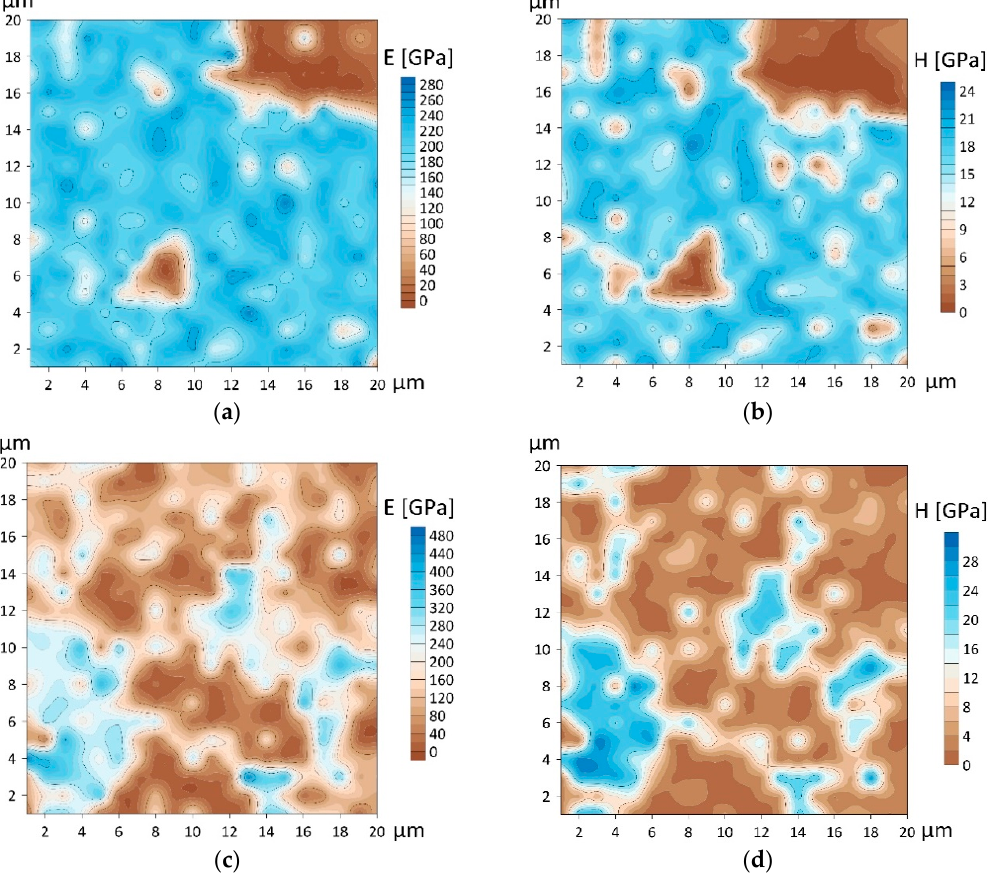
Figure 16. Elastic modulus ( a , c ) and microhardness ( b , d ) maps of CrN ( a , b ) and Al 50 Cr 50 N ( c , d ) coatings, area of 20 × 20 µm 2 .